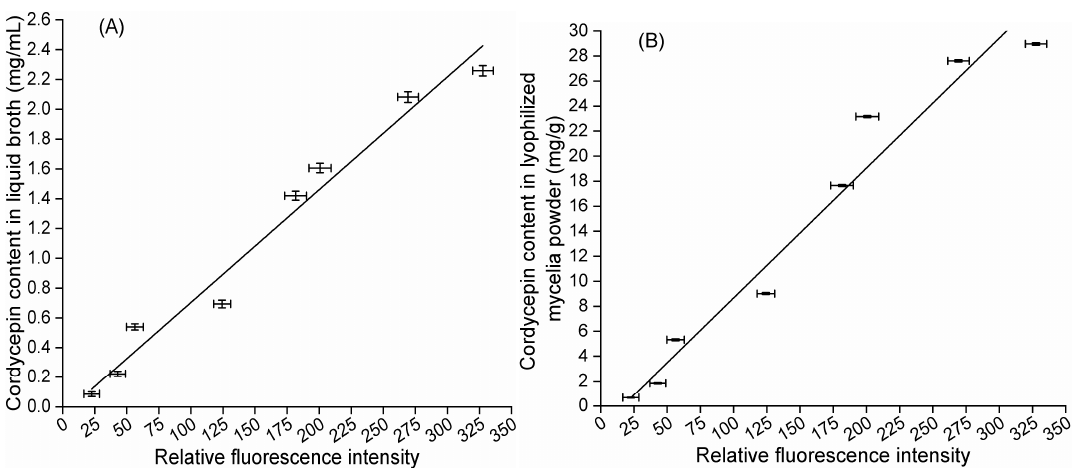
Figure 6. Quantitative correlation between cordycepin content and relative fluorescence intensity from Nile red-stained lyophilized mycelium powder of mutant CM1-1-1. ( A ) The relationship between cordycepin concentration in liquid broth and relative fluorescence intensity from Nile red-stained lyophilized mycelium powder. ( B ) The relationship between cordycepin content in lyophilized mycelium powder and relative fluorescence intensity from Nile red-stained lyophilized mycelia powder.